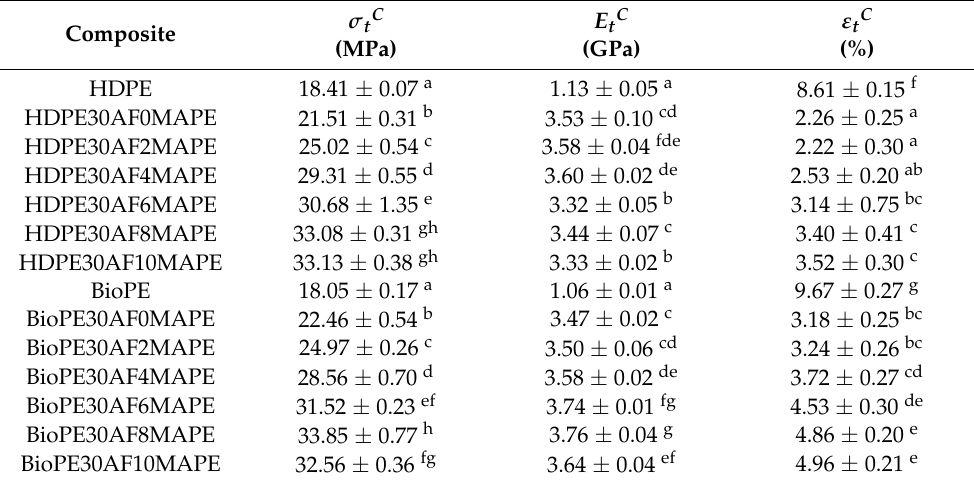
Table 3. Experimental results for the tensile strength, Young’s modulus, and strain at break for HDPE and BioPE-based composite material reinforced with 30 wt% of AF, and the impact of coupling agent